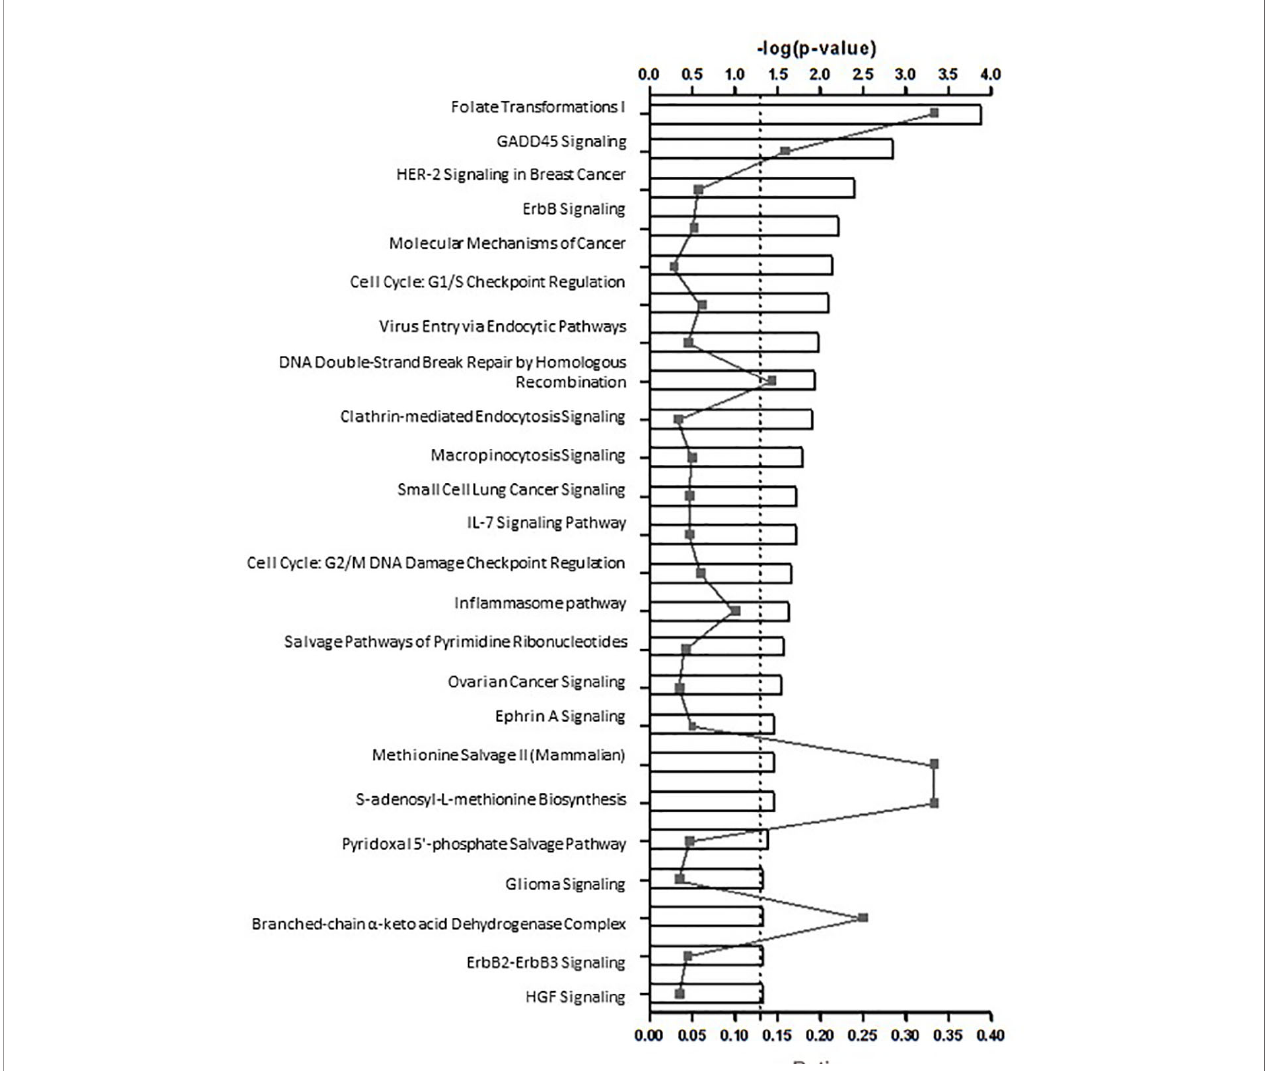
FIGURE 2 | 24 potential canonical pathways enriched in patients with autoimmune type 1 diabetes (n=20) in comparison to health controls